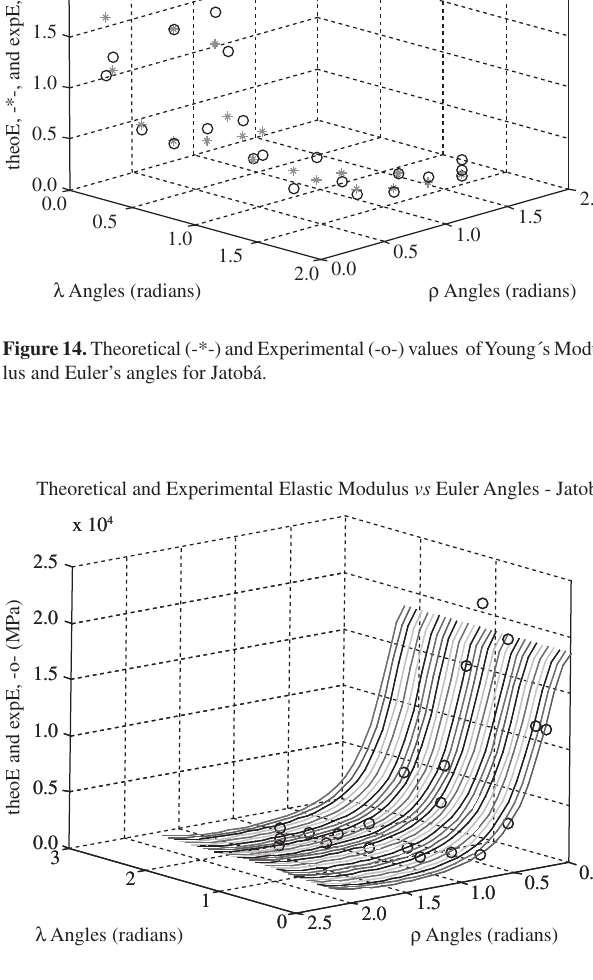
Figure 15. Theoretical and Experimental (-o-) diagram of Young’s Modulus and Euler’s angles for